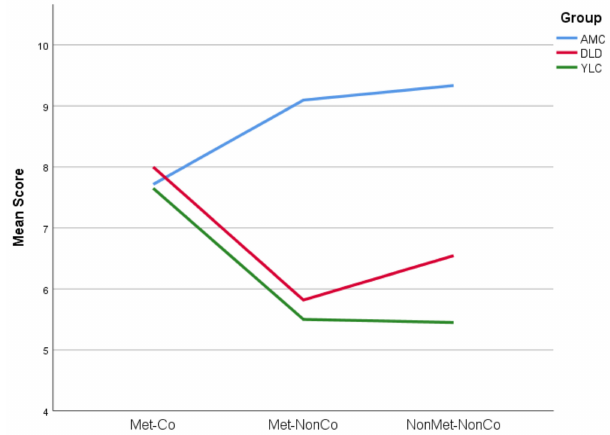
Figure 2. A graph showing the mean score for each condition by group. AMC: Aged-matched children; DLD: Developmental Language Disorder; YLC: younger, language-matched control.